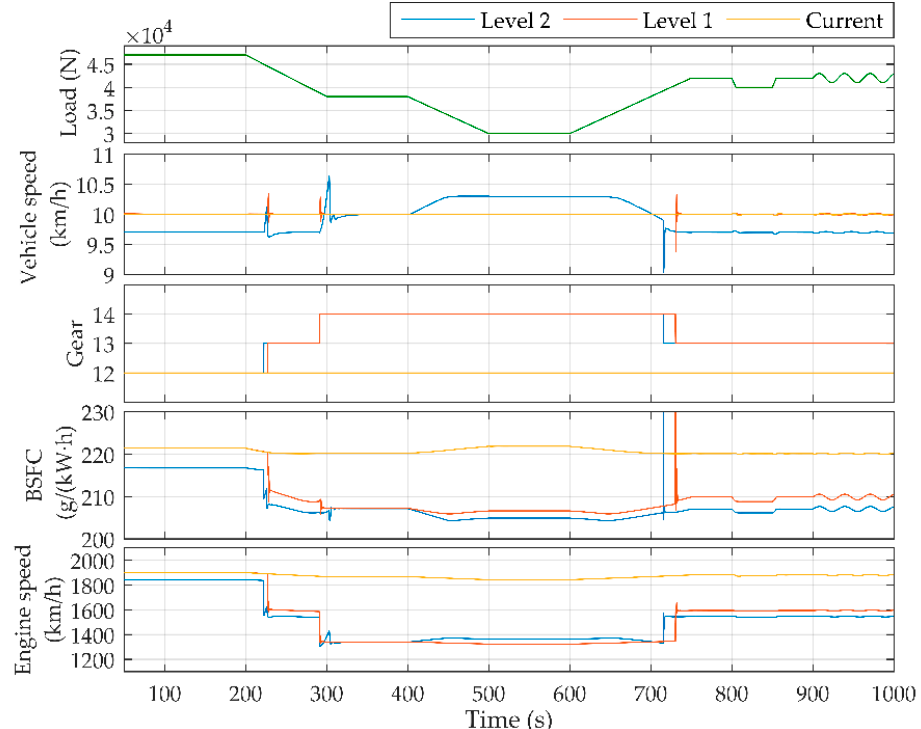
Figure 14. Simulation results of constant reference target speed.